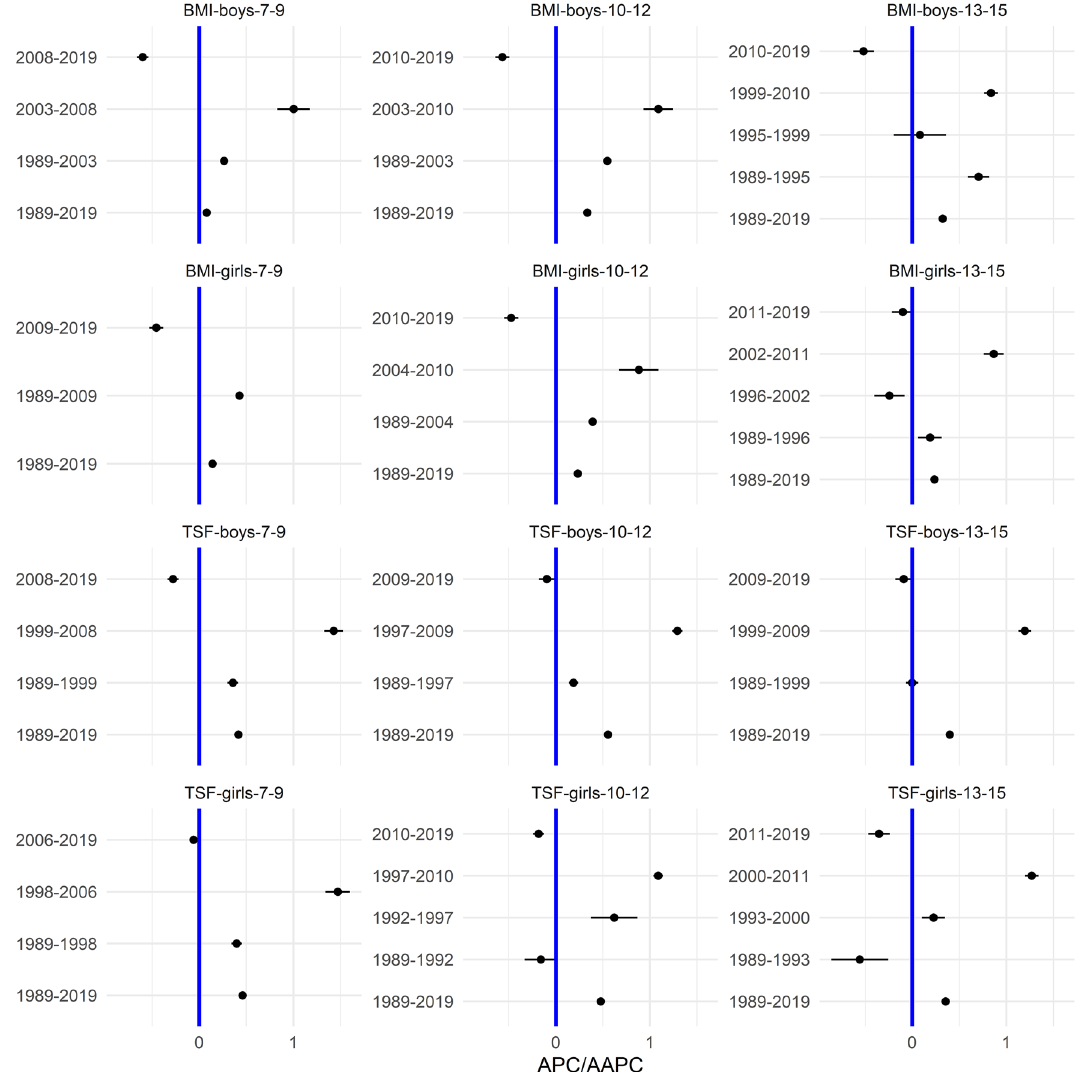
Figure 1. The estimated APC and AAPC (x-axis) with their respective 95% confidence intervals (CI) for each segment as estimated by minimizing the BIC (y-axis) for BMI and TSF by age groups (7–9-year-olds, 10–12-year-olds, and 13–15-year-olds) and gender. Positive (negative) values of APC (AAPC) imply that BMI was increasing (decreasing) during the estimated segment, when the CIs cross the vertical blue line (set at APC (AAPC) equal to zero) this implies that the results did not change during the estimated segment. See Supplementary Information for more results including the uncertainty in the estimated